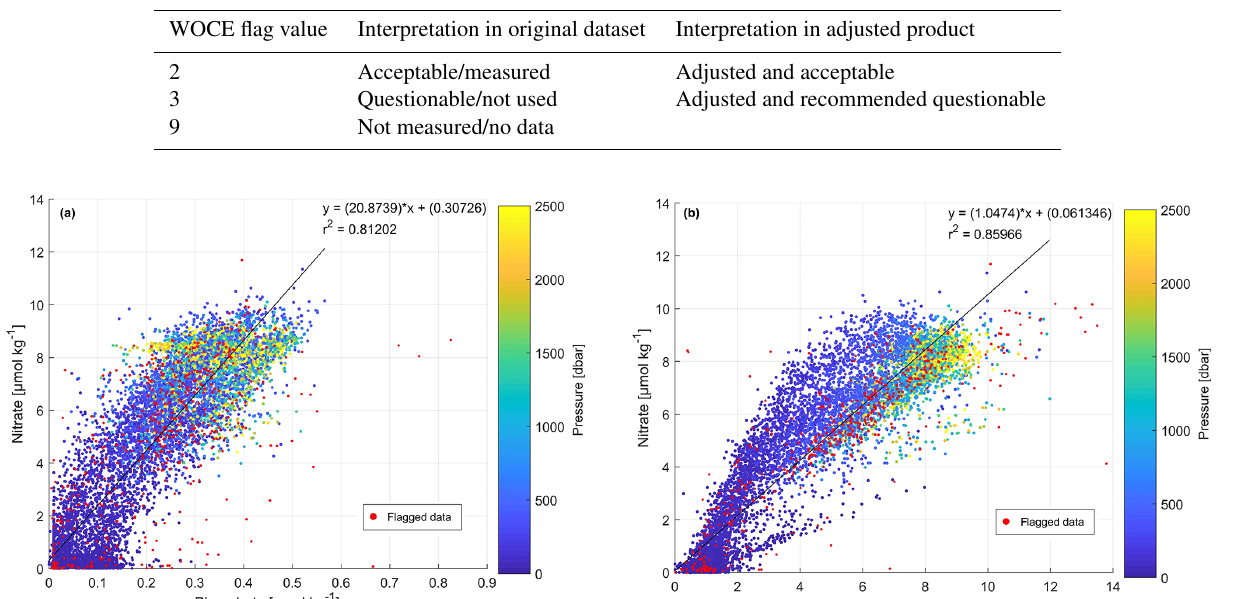
Table 3. WOCE flags used in the original data product and in the adjusted product.